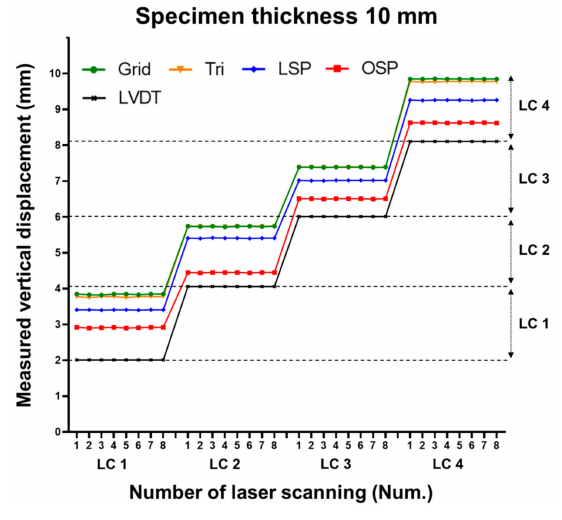
Figure 14. Comparison of vertical displacement with eight repeated laser scans (10 mm specimen).